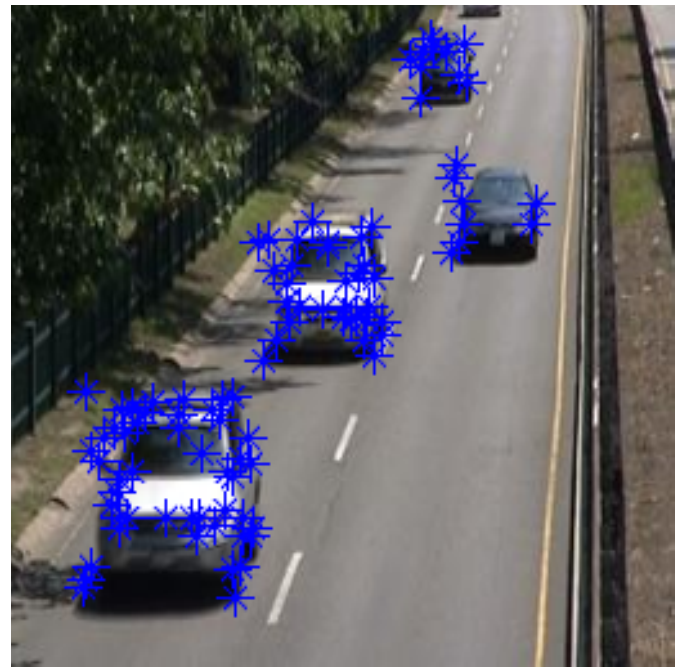
Figure 3. Feature points in the detected region of